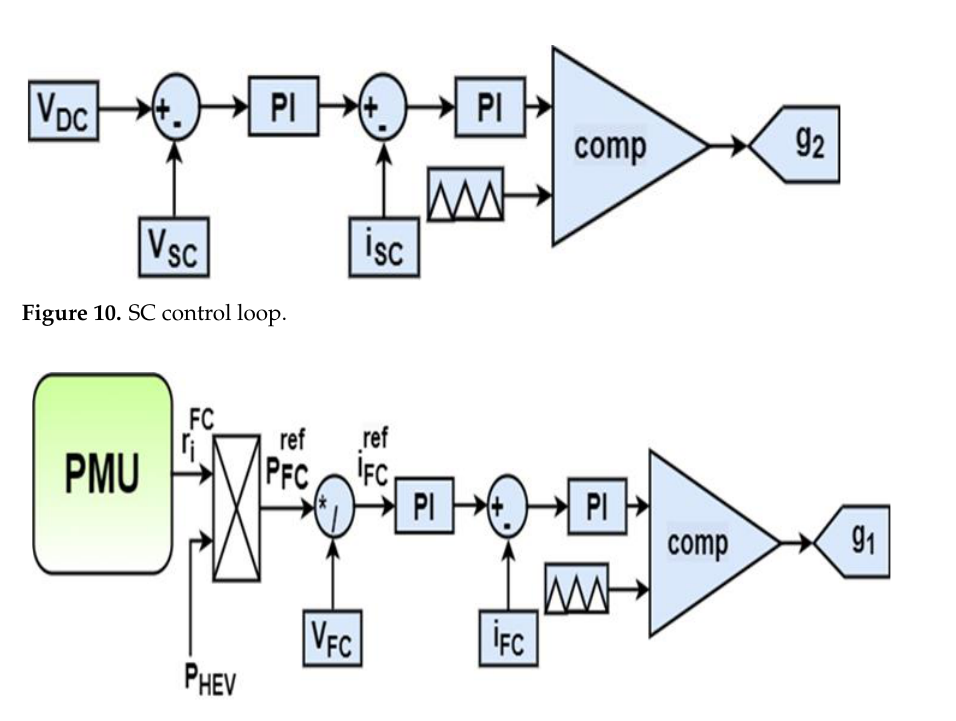
Figure 11. FC control loop.